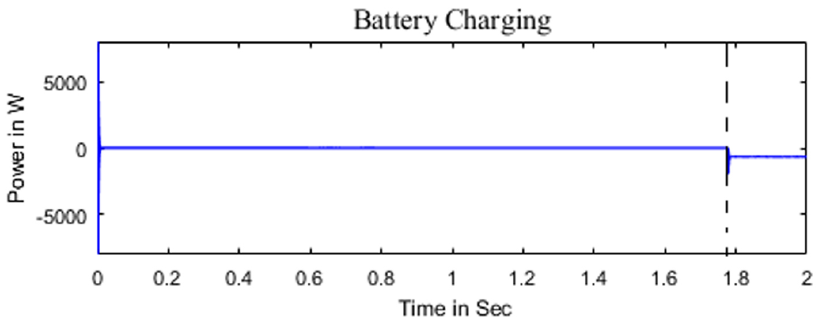
Figure 21. Battery charging condition when grid is connected to the system at 1.75 s.